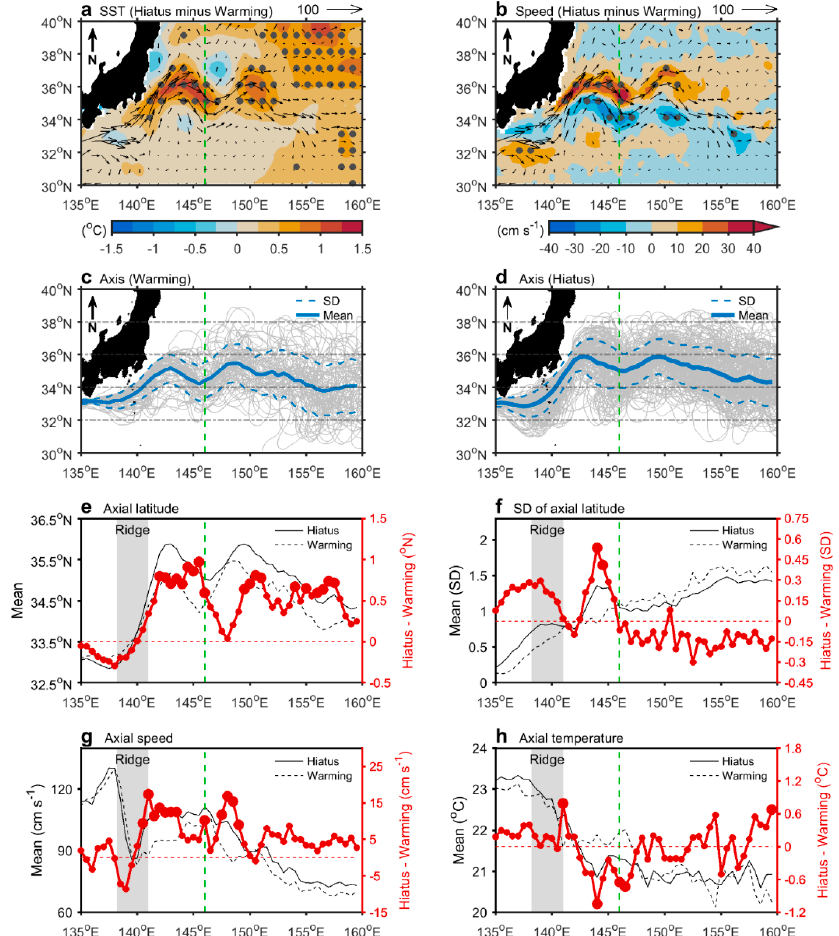
Figure 3. Intensifying and warming Kuroshio under the recent Pacific hiatus regime. ( a ) The SST difference (shading; the 1999–2013 hiatus regime minus the 1993–1998 warming regime) and mean velocity (1993–2013; vector, in units of cm s − 1 ) are shown (from OISST); ( b ) Same as ( a ), but the shading is the difference of speed (from Archiving, Validation and Interpretation of Satellite Oceanographic Data (AVISO)); ( a , b ) The gray dots indicate statistical significance above the 90% confidence level; ( c ) The monthly axis of the Kuroshio Extension (KE) jet during the warming regime (gray curves). The mean path (blue curve) and one standard deviation (SD) of the mean path (blue dashed curves) during the warming regime are shown. The path is defined as the 90-cm contour of the sea surface height according to Figure S1; ( d ) Same as ( c ), but for the hiatus regime; ( e ) The mean axial latitude during the warming regime (black dashed curve) and during the hiatus regime (black solid curve), and the difference of axial latitude (red curve; the hiatus regime minus the warming regime) are shown. The